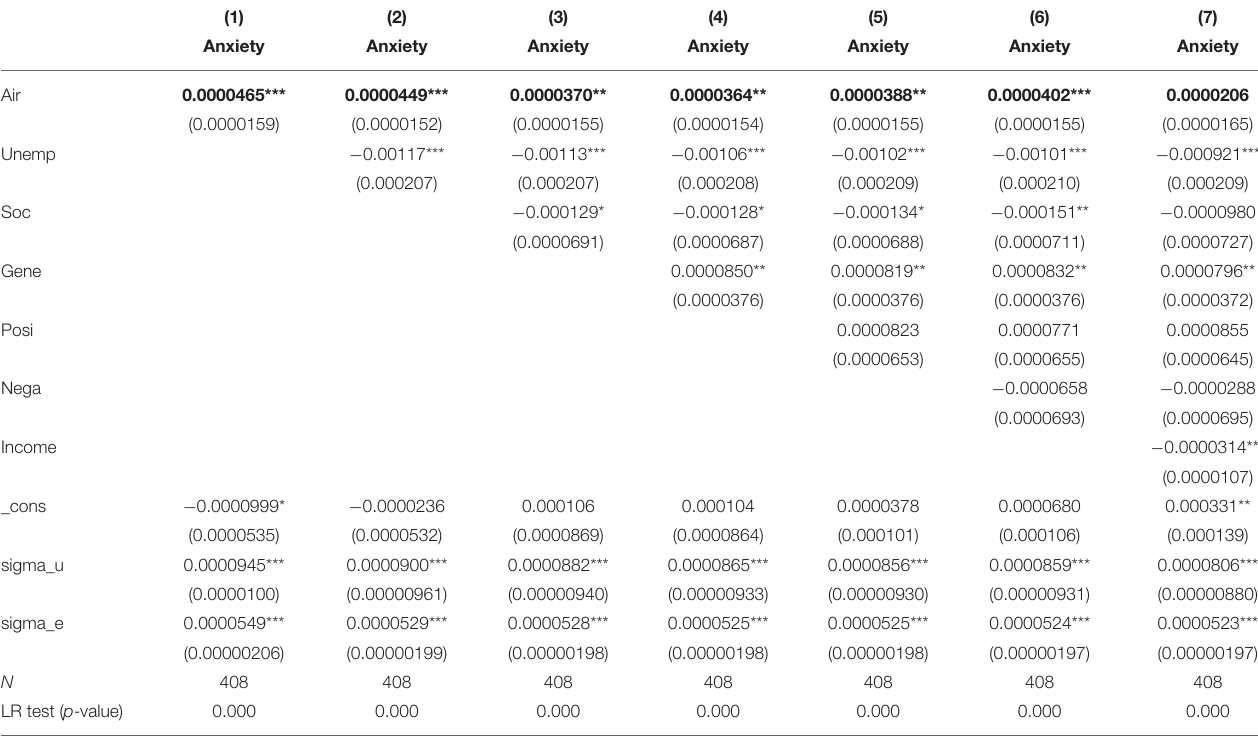
TABLE 6 | Regression results of air pollution on anxiety under complete sample.